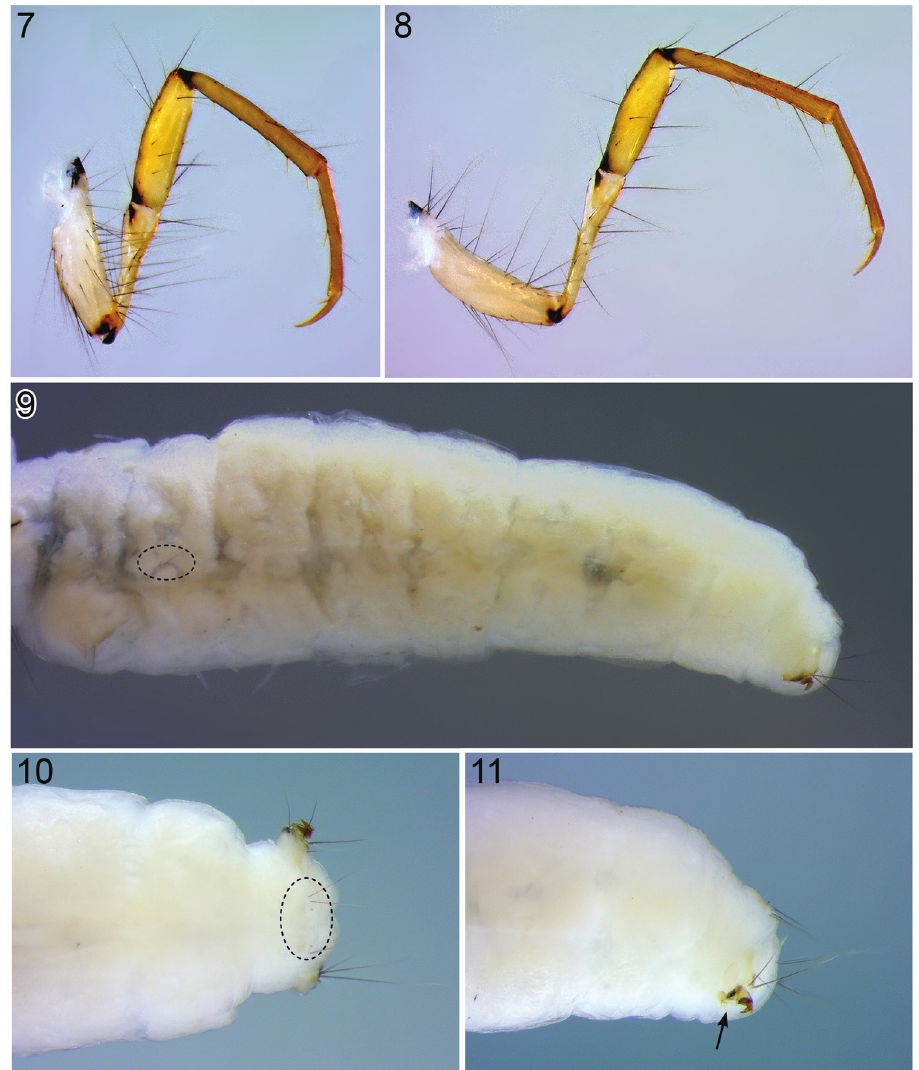
Figures 7–11. Oecetis mizrain , 5 th instar larva . 7 Left middle leg, anterior face, 50× 8 Left hind leg, ante- rior face, 60× 9 Abdominal segment I–X, lateral view, 25× 10 Abdominal segment IX, dorsal view (dashed oval indicates abdominal segment IX tergite), 50× 11 Anal proleg, lateral view, 50× (arrow indicates sec- tion of anal proleg where prominent spines or tines may be present in other Leptoceridae). Thorax . Prothorax fully covered by 2 large sclerites, light brown to brown; small fragments of sclerites present posterior to each pronotal half (Fig. 4). Including anterior setal rows, 25–28 setae of varying lengths distributed over each pronotal half (Figs 4, 5). Mesonotum with 2 large sclerites covering about 50% of its area while not